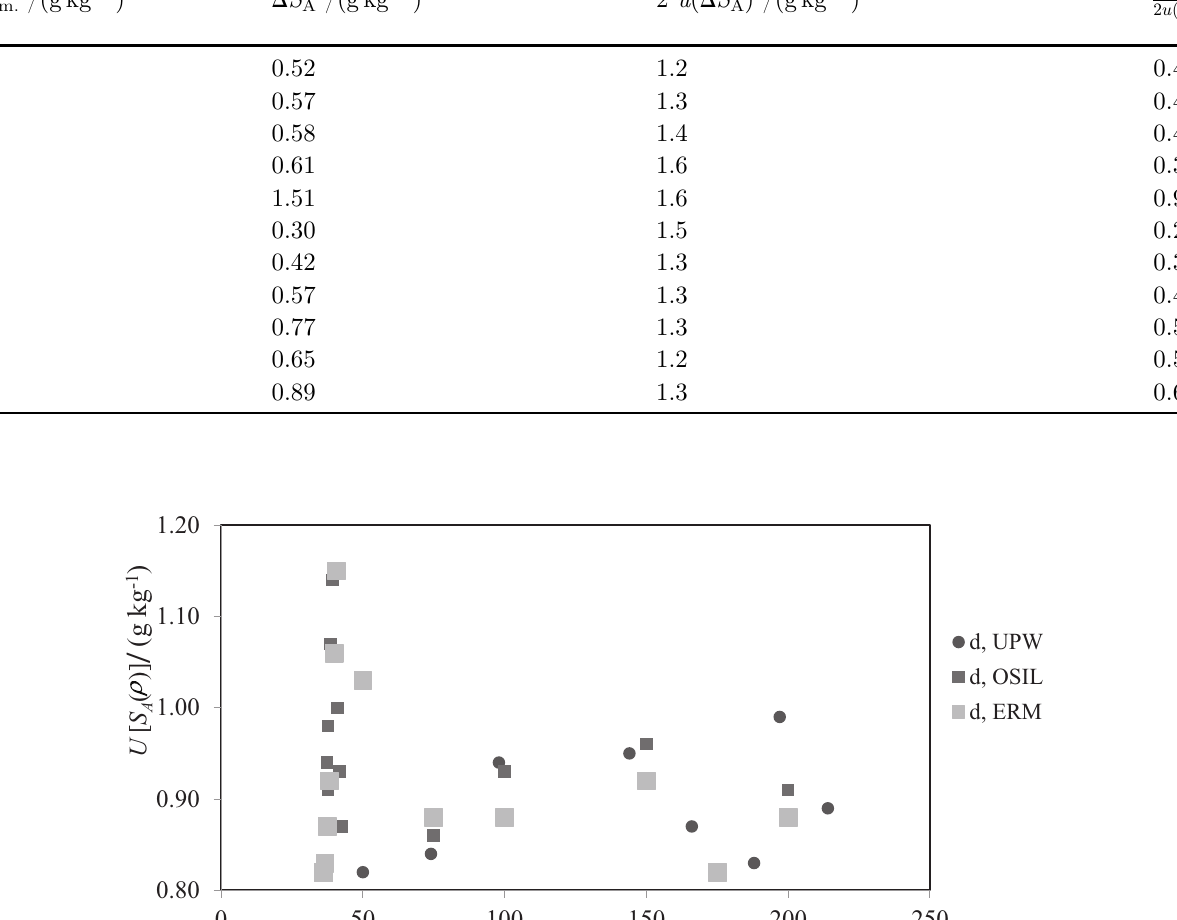
Table 7. Assessment of the metrological compatibility from the relative differences between pairs of salinity values by densimetry and by refractometry ( S